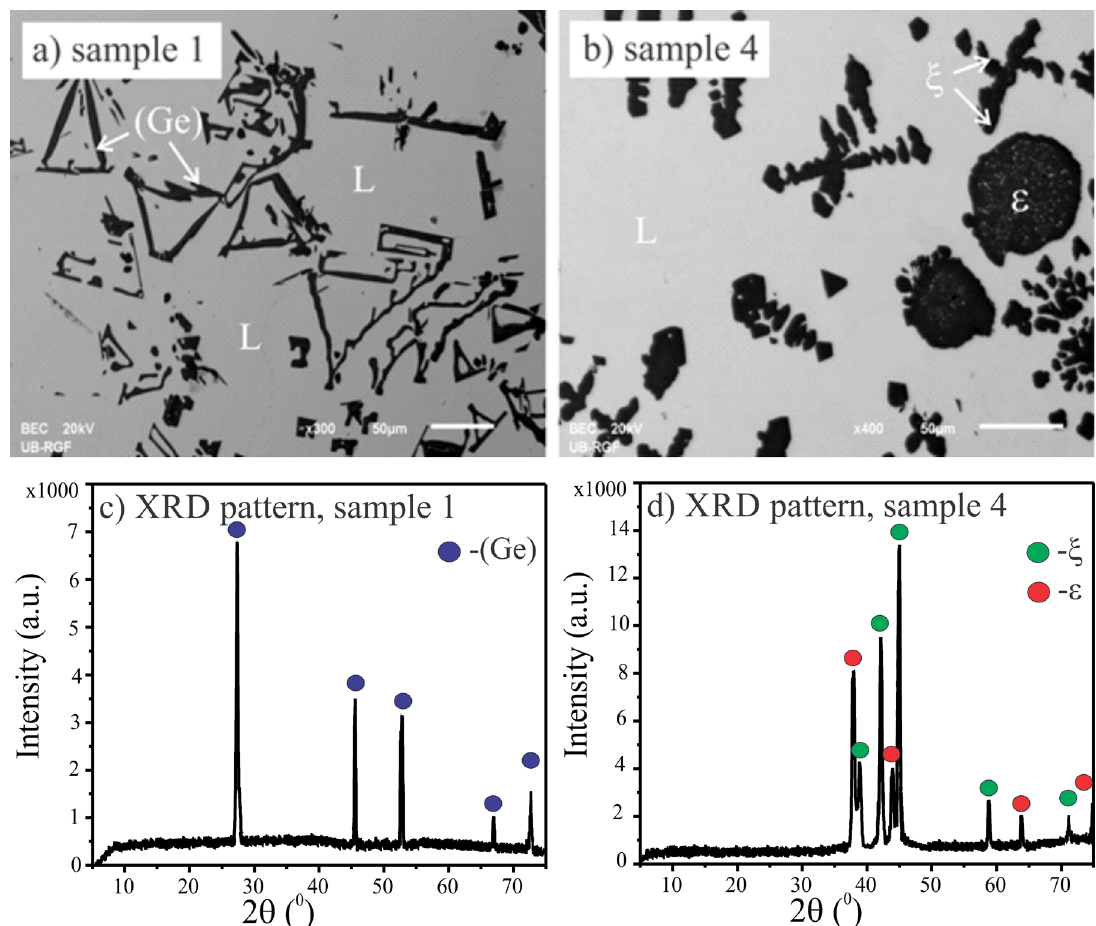
Figure 4. SEM-BSEI micrographs and XRD patterns of samples 1 and 4 annealed at 600 °C for five